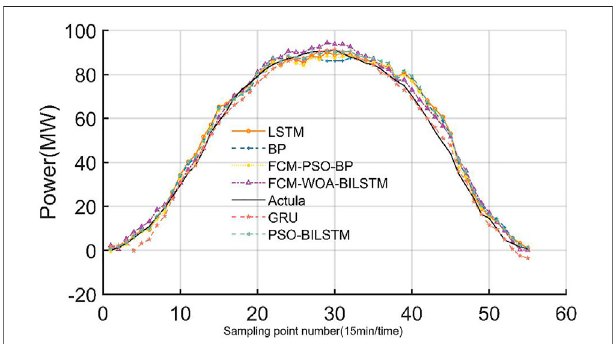
FIGURE 8 | 14 June 2019 (sunny).